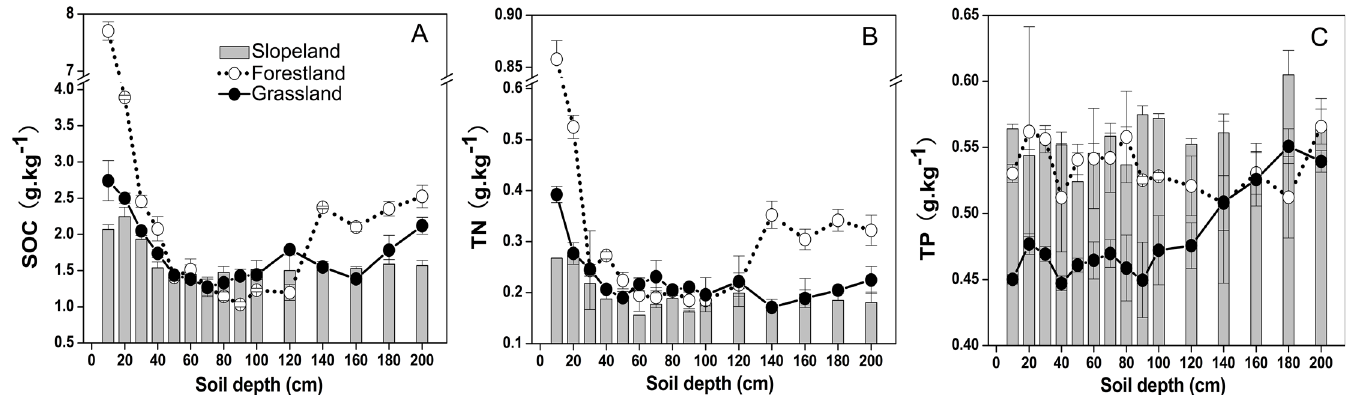
Fig 1. Dynamic distribution of SOC (A), TN (B) and TP (C) concents at a soil depth of 0 – 200 cm. The error bars are the standard errors.